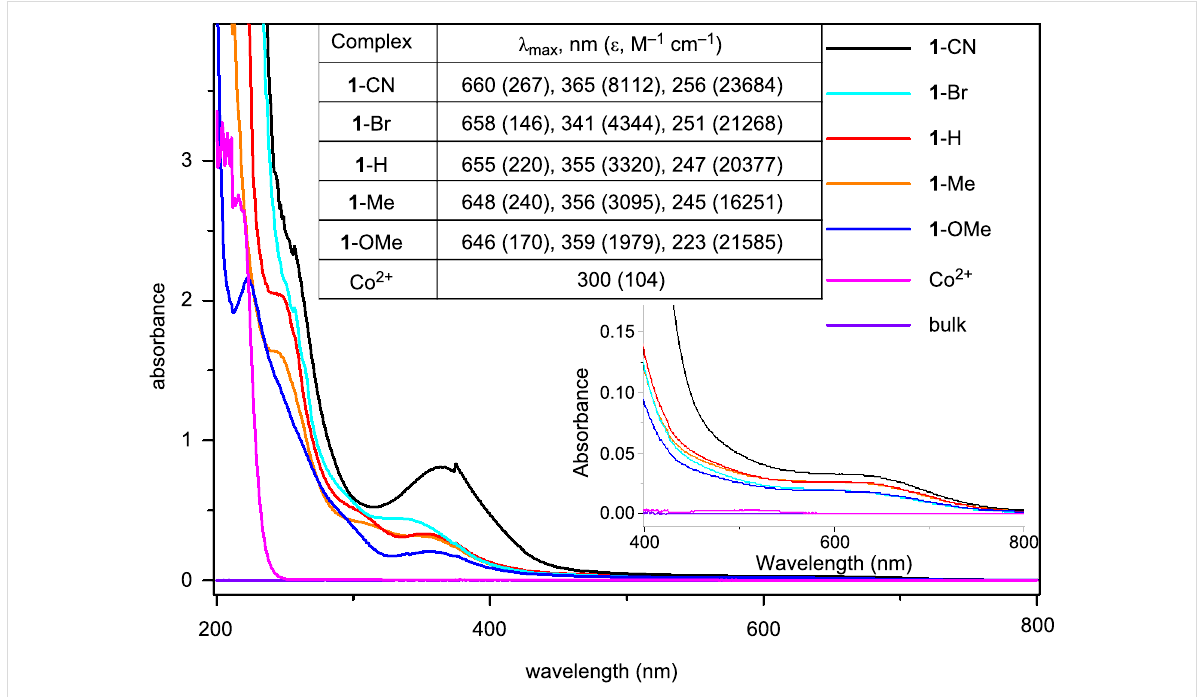
Figure 2: UV–vis absorption spectra of 1 -R in H 2 O based on measurements in 10 − 4 M solution. Inset: scale from 400 nm to 800 nm and the λ max for 1